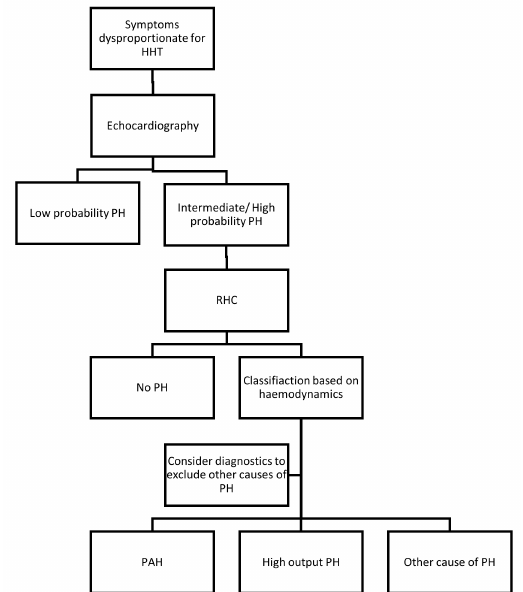
Figure 2. Flow chart diagnosis of PH in HHT. HHT, hereditary haemorrhagic telangiectasia; PH, pulmonary hypertension; RHC, right heart catheterisation; PAH, pulmonary arterial hypertension. Echocardiography can estimate systolic PAP from the right atrium to right ventricle pressure gradient based on the peak tricuspid regurgitation velocity (TRV) in combination with secondary echocardiographic signs of PH. Category A: an increased right ventricle/left ventricle ratio, flattening of the interventricular septum; category B: increase diameter of the pulmonary artery, short right ventricular outflow Doppler acceleration time, and increased early diastolic pulmonary regurgitation velocity; category C: dilation of the inferior vena cava or right atrial dilation. Based on